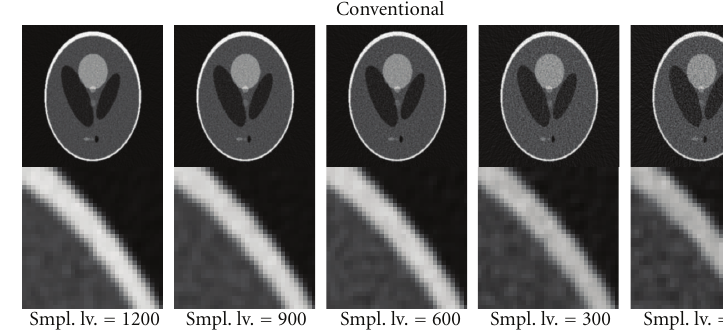
Figure 5: Comparison of the reconstructed tomography images derived using the Bayesian method and conventional FBP under the Poissonian noise. The top row shows the results of our method, and the bottom one shows the results of the conventional FBP method. Each column corresponds to the strength of the observation noise which can be denoted as the number of sampling in the acceptance rejection method. We show the magnification of a part of the reconstructed images around the edge of the phantom, whose location is indicated by a white rectangle in the true image.